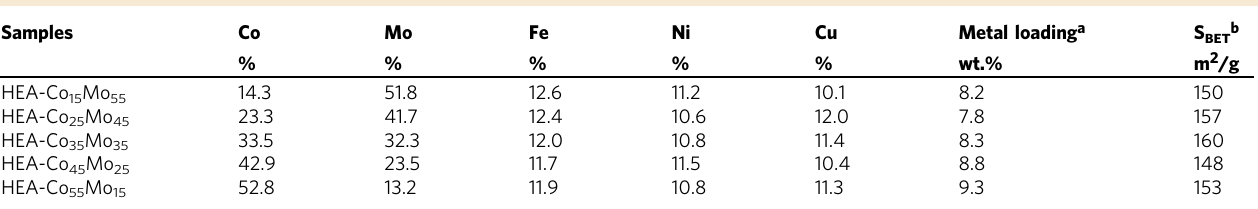
Table 1 List of HEA-Co x Mo y catalysts employed in this study